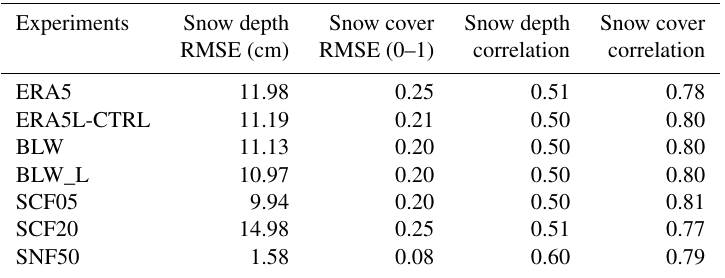
Table 6. Root mean square error (RMSE) and temporal correlation for snow depth (versus stations data) and snow cover (versus IMS satellite) for ERA5 and the different experiments. The time series of the observation and experiments were first averaged over the 33 stations before the score calculations were carried